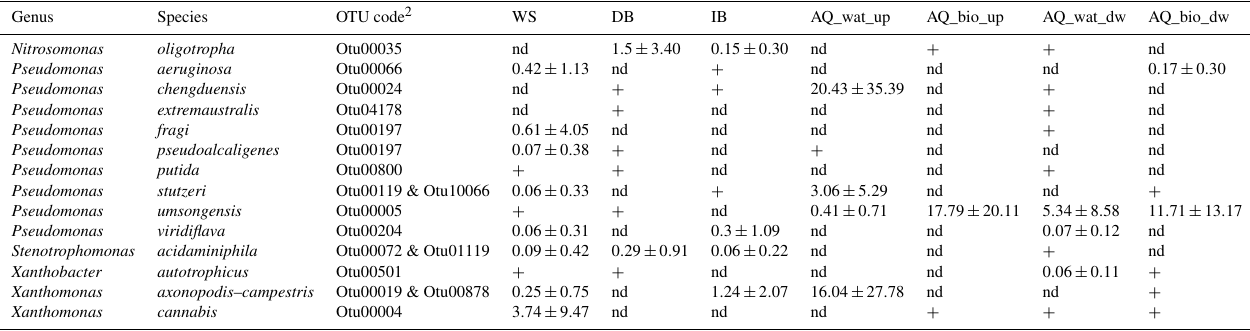
Table 3. Relative distribution of tpm reads per OTU (mean ± SD) shared between the upper compartments and the aquifer that were allocated to well-defined species 1